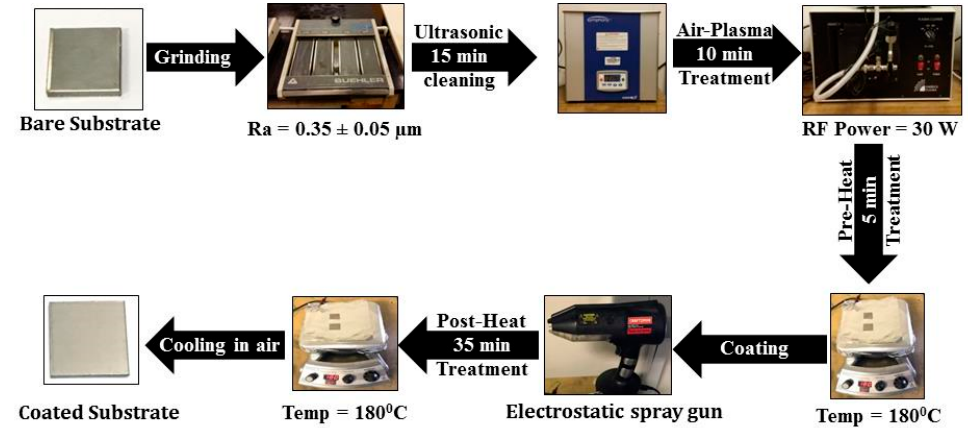
Figure 2. Flow chart listing the steps involved in surface preparation and coating of the steel substrates.